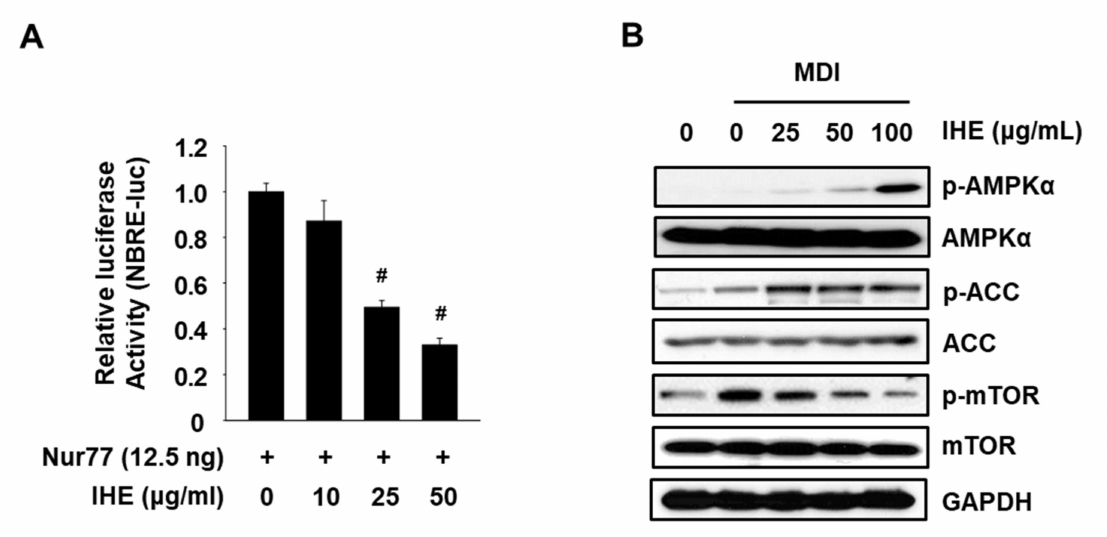
Figure 3. IHE simultaneously targets Nur77 and AMPK α . ( A ) NBRE-Luc (25 ng) was cotransfected with Flag-Nur77 (12.5 ng) into MiaPaCa-2 cells for 4 h and treated with IHE for 18 h. ( B ) 3T3-L1 cells were treated with IHE in the presence of MDI for 12 h. AMPK α expression was then determined by Western blot analysis; # p < 0.001 vs. DMSO